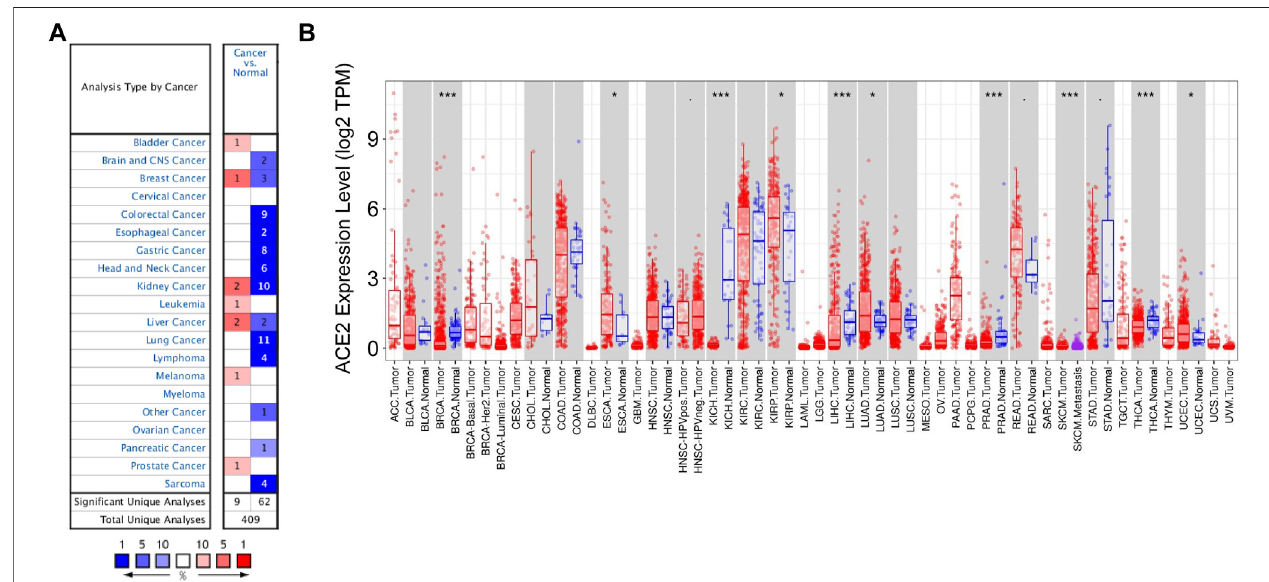
FIGURE1 | Expression levels ofTMPRSS2 indifferent types of cancers. (A) Relative expression of TMPRSS2 in different cancers compared withnormal tissues in the Oncomine database. (B) TMPRSS2 expression levels in different tumor types from the TCGA databases were detected by TIMER (* p < 0.05, ** p < 0.01, *** p <